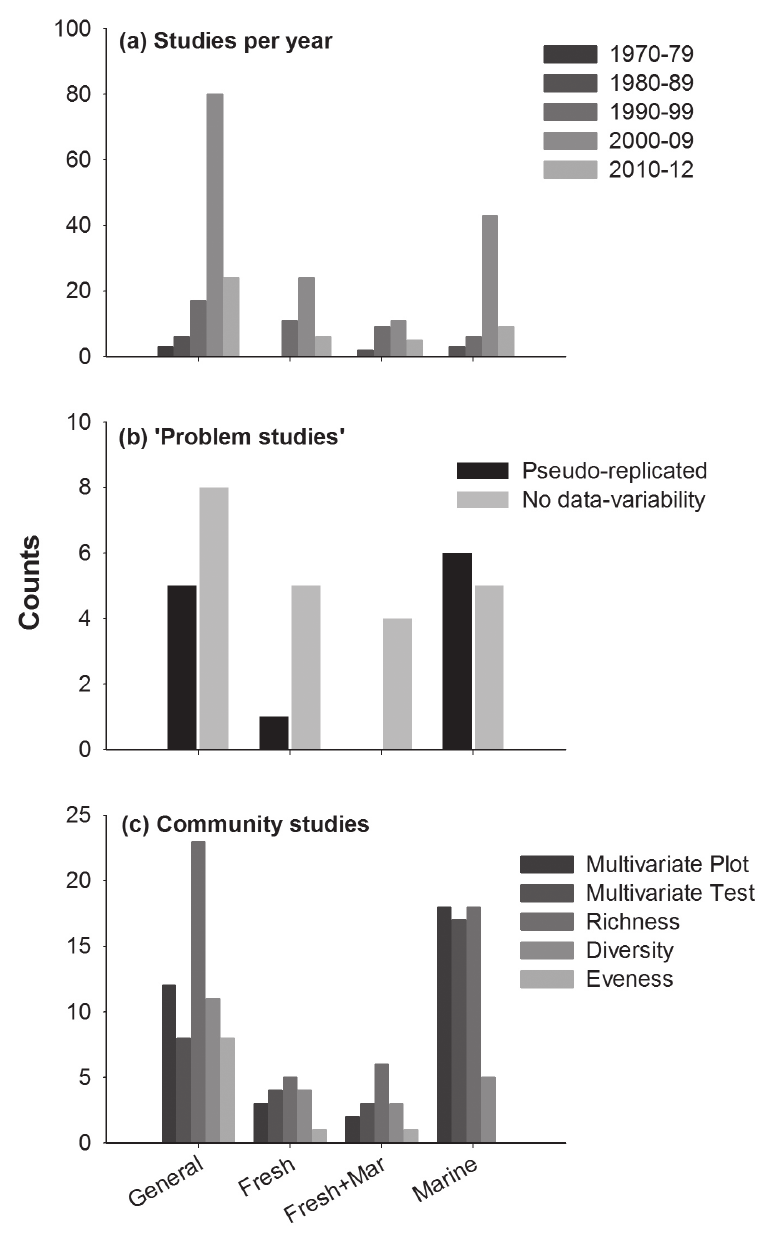
Figure 1. Aquatic invasion impact experiments published in general, freshwater, marine, and both fresh- water and marine journals (see S1 for journal classification) a decadal trend in publication rates (the last bar only include studies published 2010–12) b Studies where the experimental design was spatially pseu- do-replicated or did not replicate treatment or control plots, and studies that did not report any measure of variability for impact data c Community impact studies that quantified impact with graphical display, multivariate inferential tests, or on taxonomic richness, diversity or